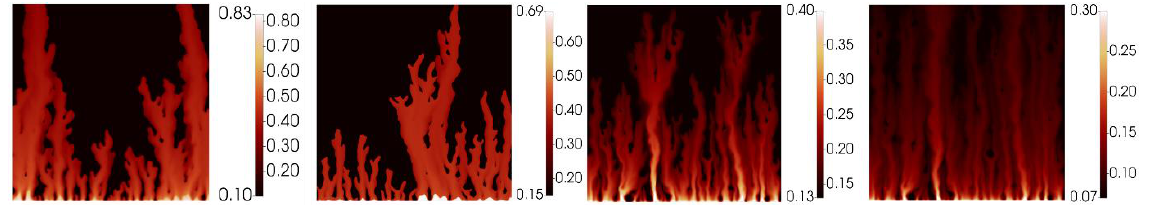
Figure 16. Finger patterns for displacement of 412 mPa.s, 616 mPa.s, 2000 mPa.s and 7000 mPa.s oil ( left to right ) at the point of water breakthrough (0.148, 0.08, 0.043, & 0.035 PV, respectively).